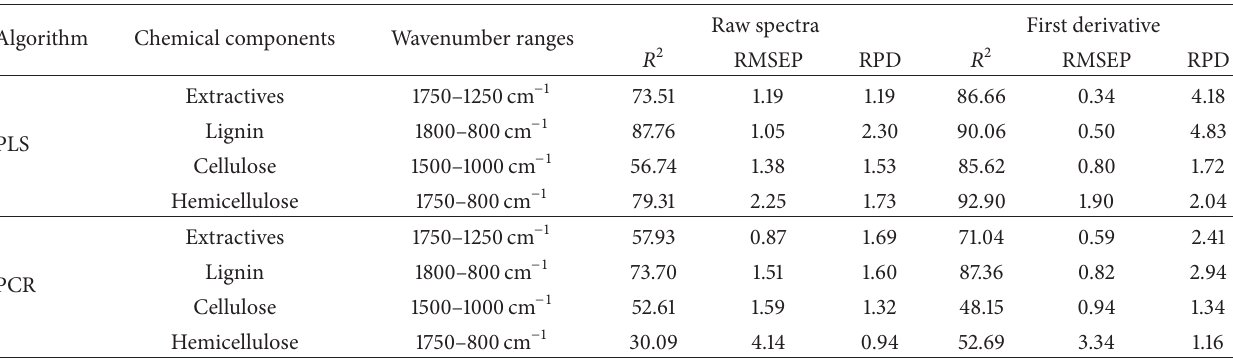
Table 2: Calibration and predictive results of FT-IR based multivariate models.